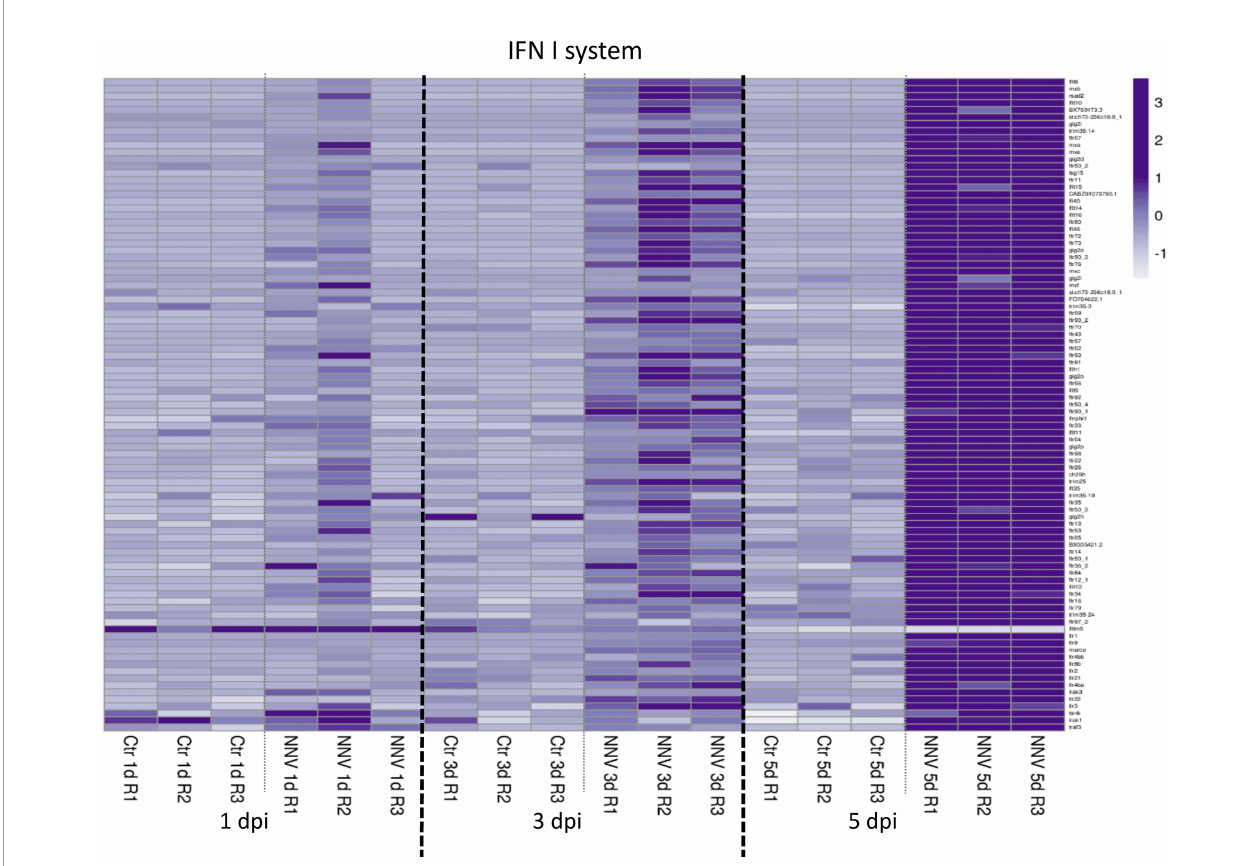
FIGURE 8 | Heatmap representing the DEGs linked to the type I IFN system at 1, 3, and 5 dpi. A heatmap was constructed with the TPM expression values of the DEGs. Expression levels are represented as row-normalized values on a white – purple colour